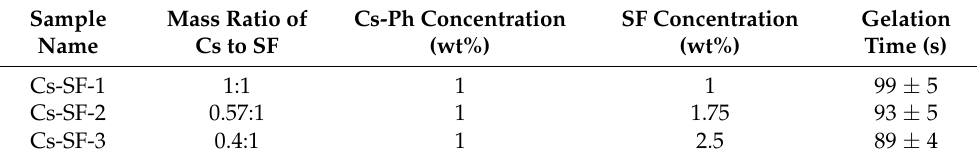
Table 2. Parameters and gelation time of Cs-SF hydrogels.